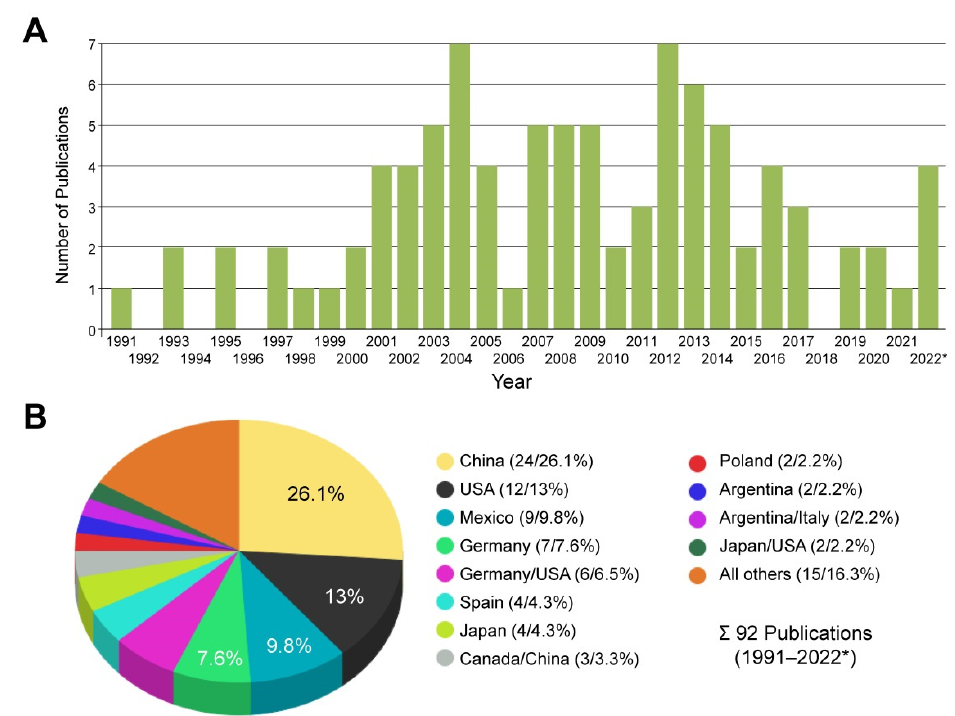
Figure 2. Studies using CFSC in articles published during 1991–2022. ( A ) Since the establishment of CFSC, reports using this cell line are published on a regular basis. Studies using CFSC were identified by searching the PubMed database or the Google search engine. The search was conducted on 19 August 2022. ( B ) Most studies that used CFSC were conducted in China (26.1%), USA (13%), Mexico (9.8%), and Germany (7.6%). For details see also Supplementary Table S1. The cell line was also used in joint studies from laboratories located in different countries. * Please note that papers for 2022 only cover the period from January to the middle of August.